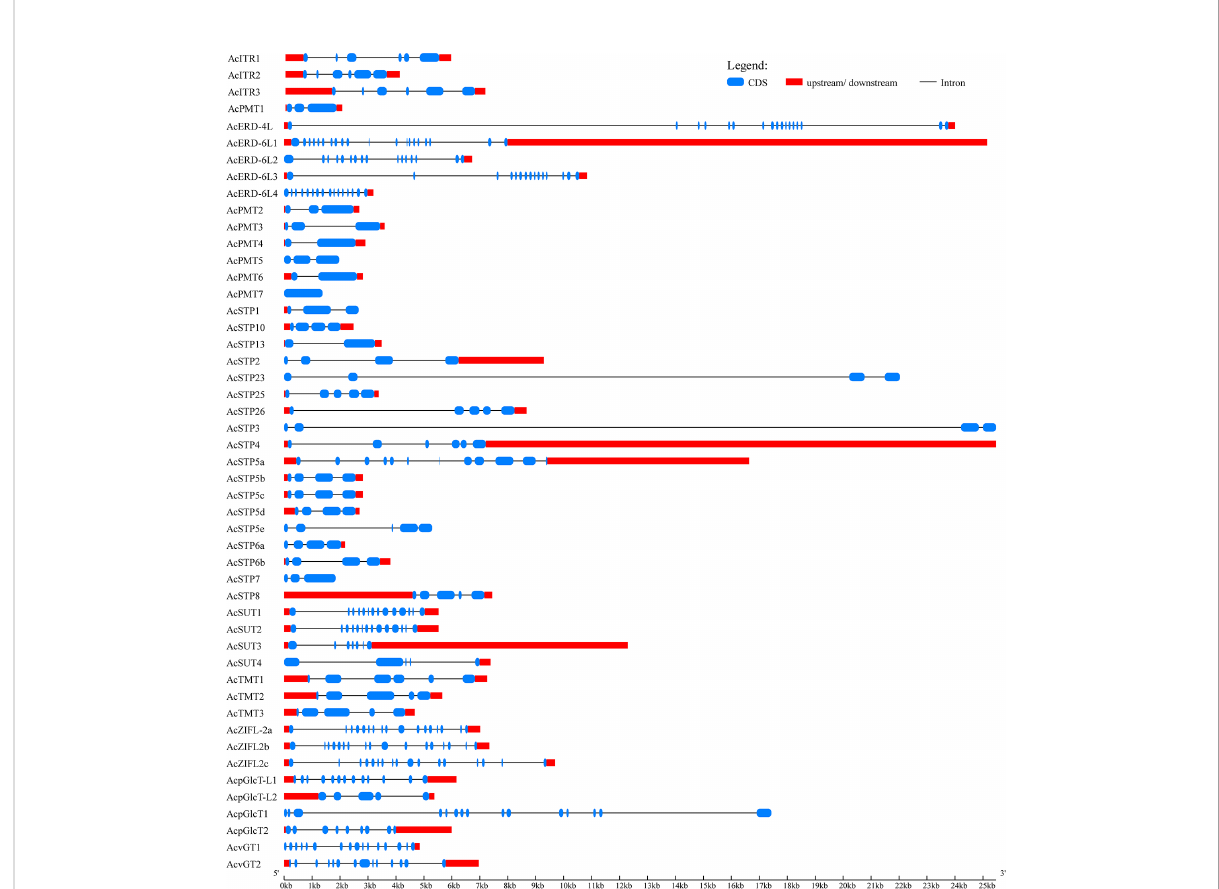
FIGURE 2 Exon – intron structure of sugar transporter genes identi fi ed in pineapple. The gene models of sugar transporters are shown in a graphic representation using the online Gene Structure Display Server (GSDS 2.0). Introns are represented as black lines; blue boxes show coding sequences, and red boxes represent upstream or downstream